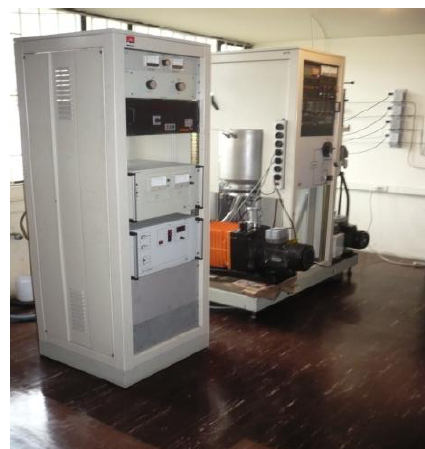
Figure 1. Alcatel HS 2000 RF sputtering